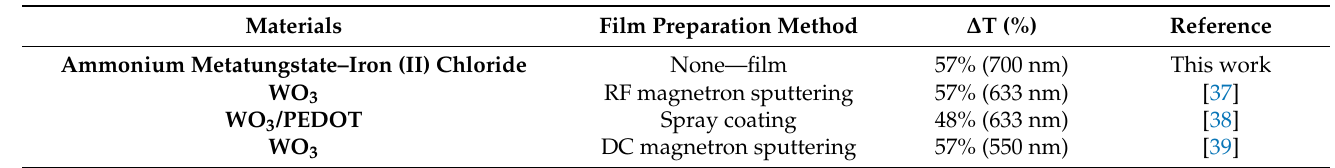
Table 2. Comparison of electrochromic (EC) materials, film preparation methods, and transmittance modulation ( ∆ T) between the literature and this work.